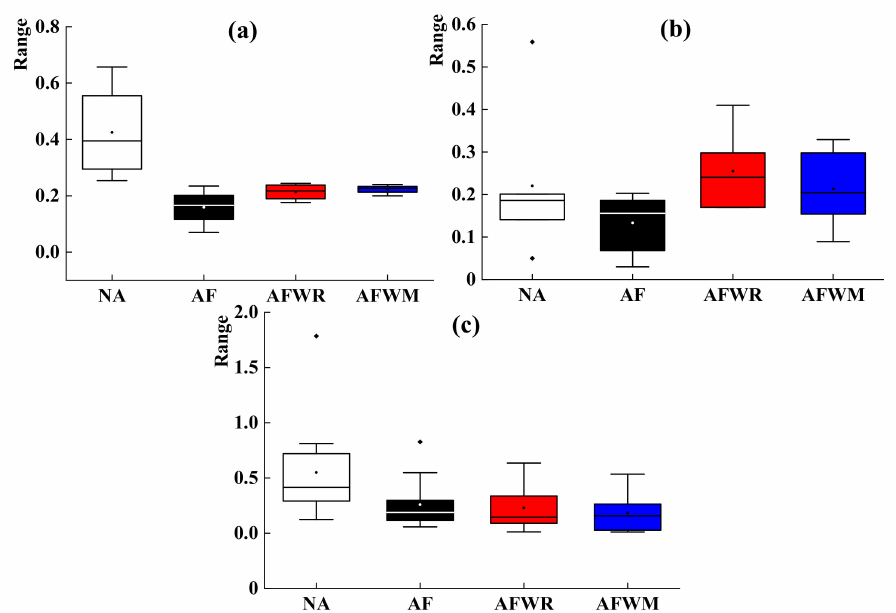
Figure 12. RE of the four assimilation settings for different flood levels: ( a ) large flood; ( b ) medium flood; and ( c ) small flood.